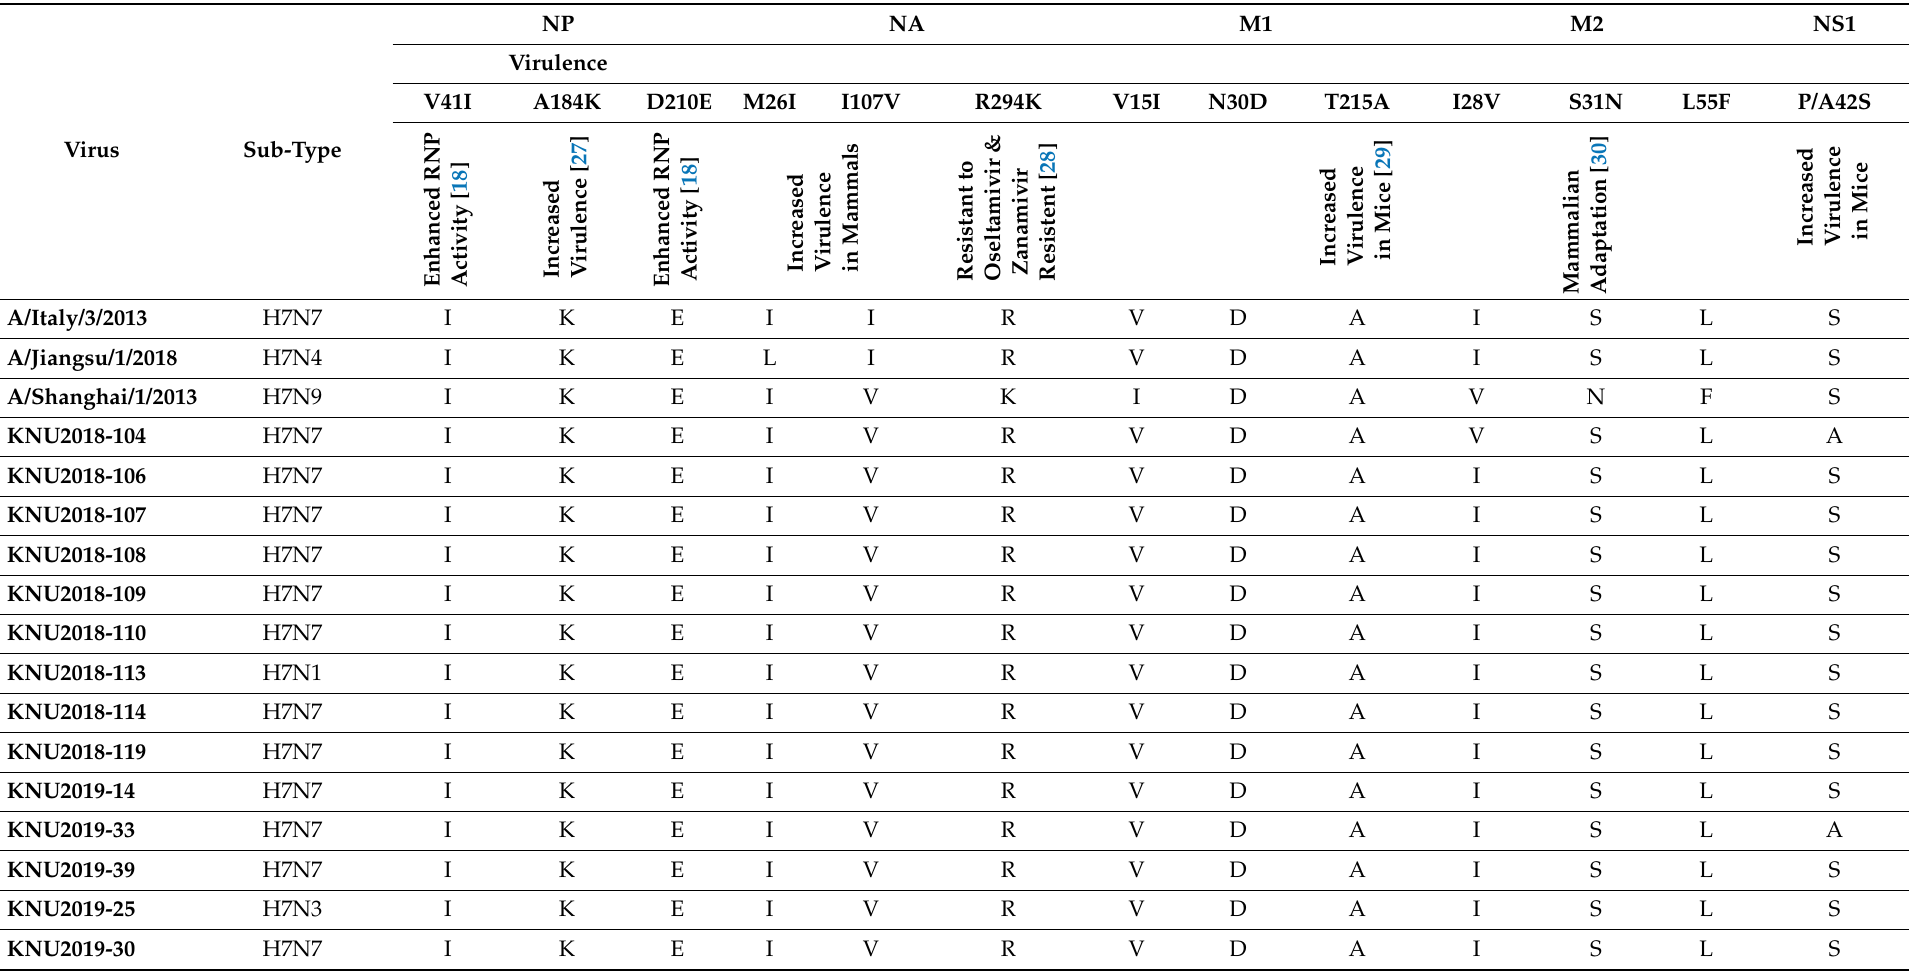
Table 2. Summary of data obtained from the mutational analysis of NP, NA, M1, M2, and NS1 segments from the H7 isolates sampled during 2018–2019 in the Republic of Korea.